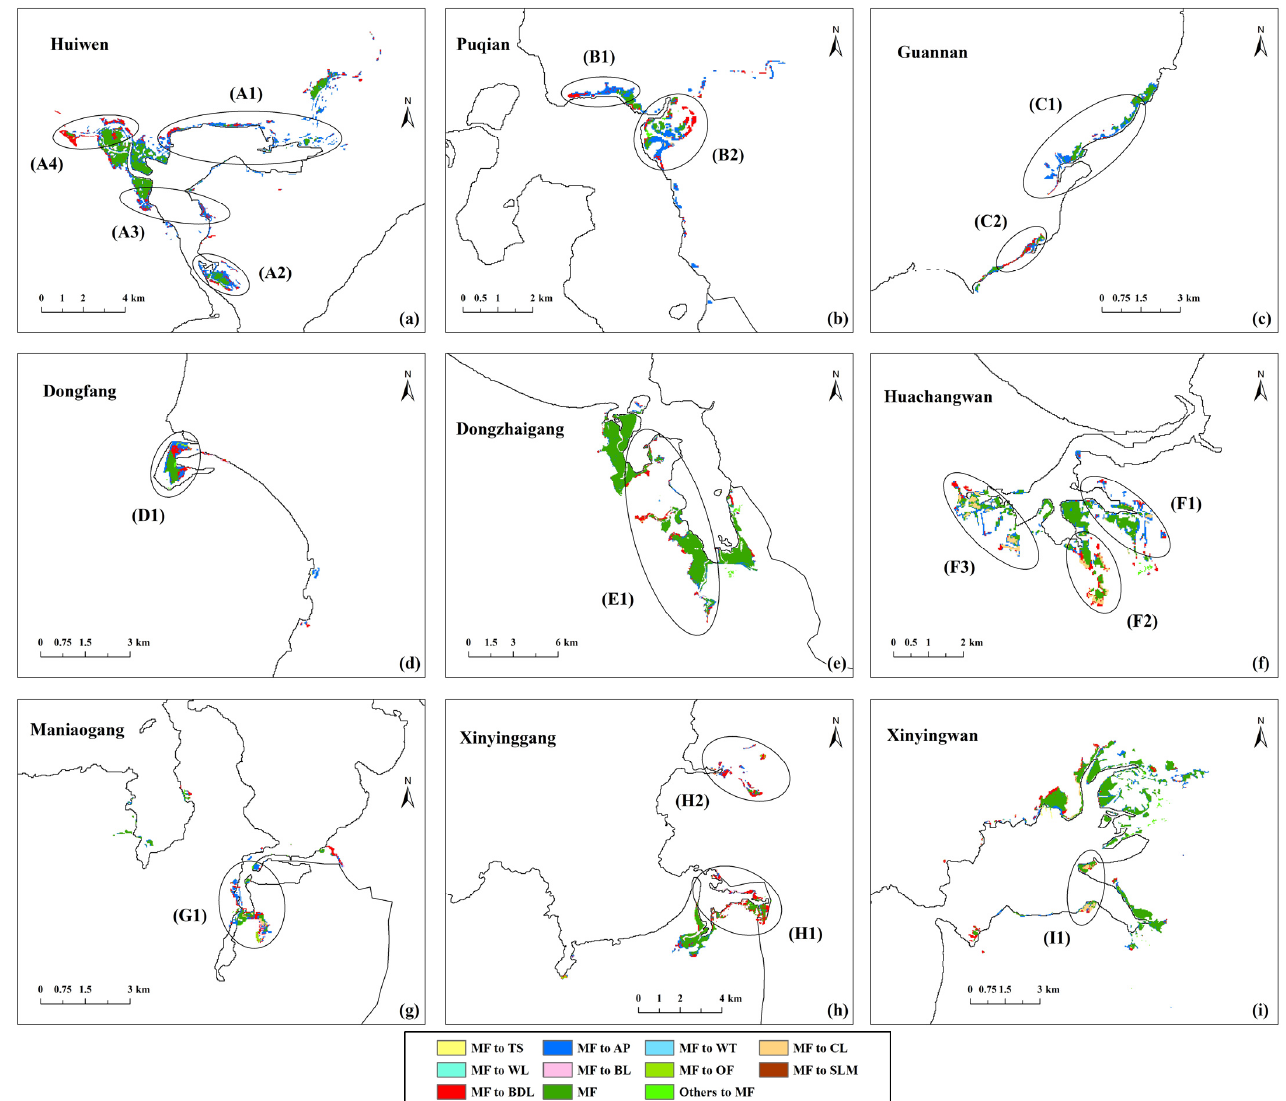
Figure 9. Land cover changes of mangrove forests ( a )–( i ) from 2017 to 2037 under EDS.